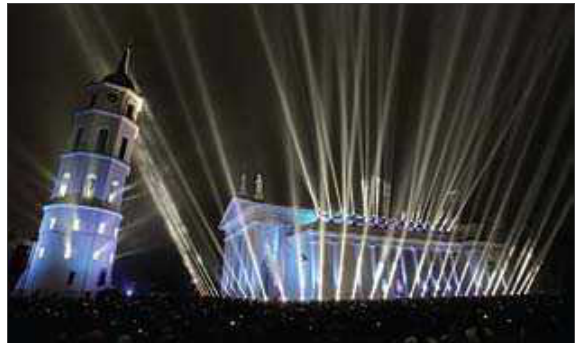
Fig. 8. Vilnius cathedral during light performance by Gert hof,